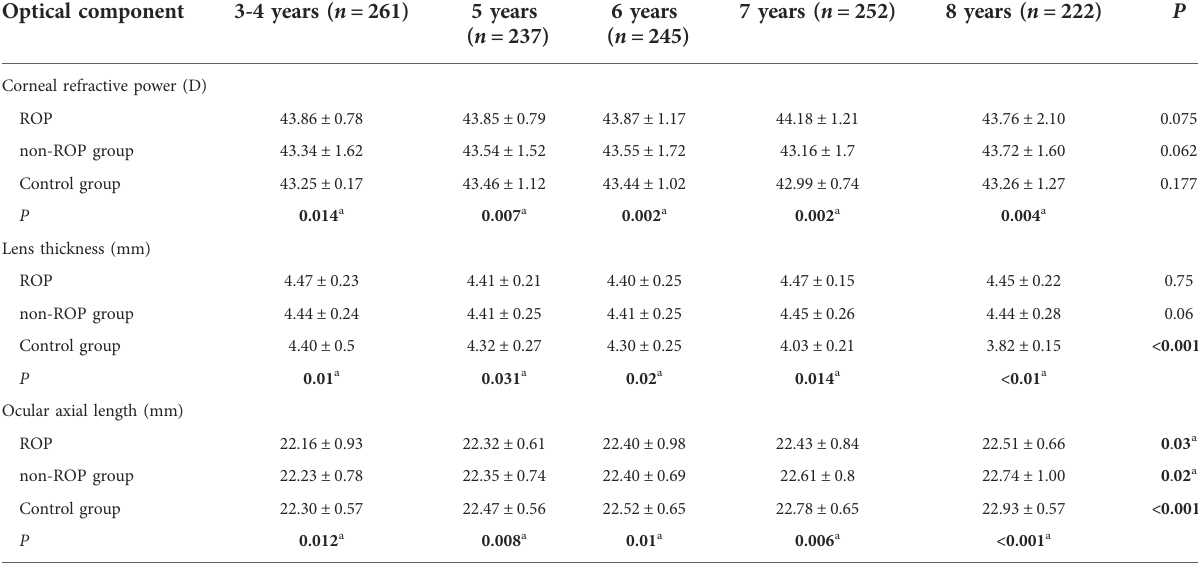
TABLE 3 Corneal refractive power, lens thickness, and axial length of subjects at different ages in the three groups. Optical